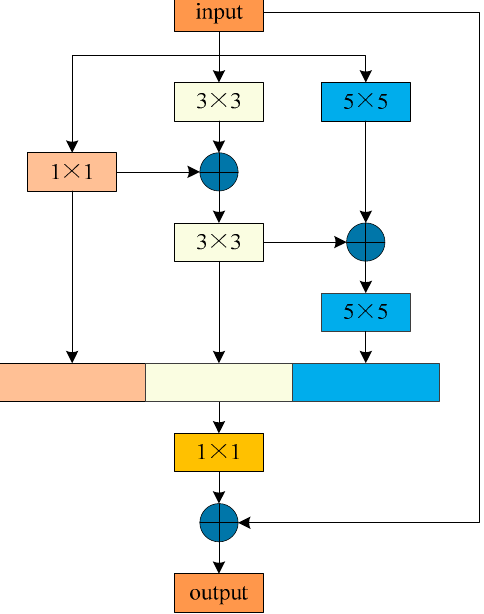
Figure 2. The structure of MFEM.